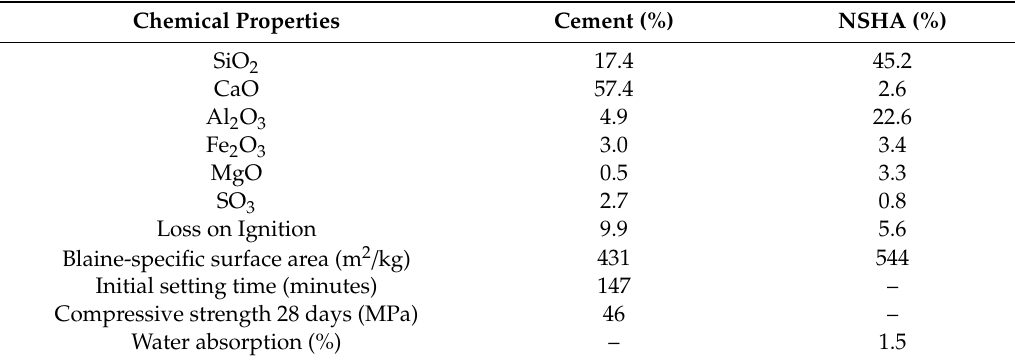
Table 3. Chemical composition of cement and NSHA